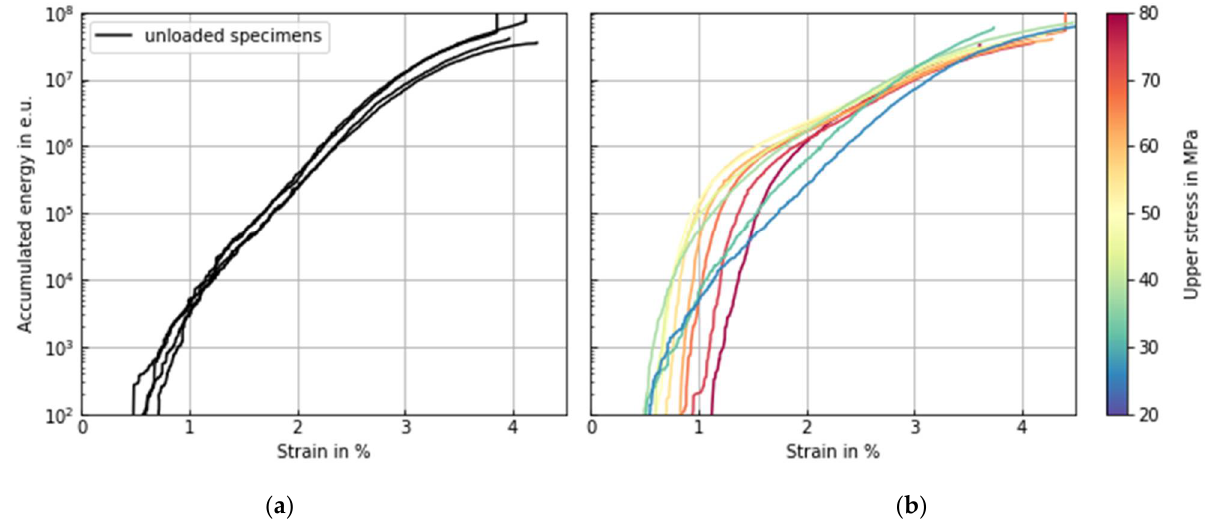
Figure 6. Accumulated acoustic energy in energy units (1 e.u. ˆ = 1 × 10 − 21 J): ( a ) unloaded specimens; ( b ) preloaded specimens sorted by upper stress